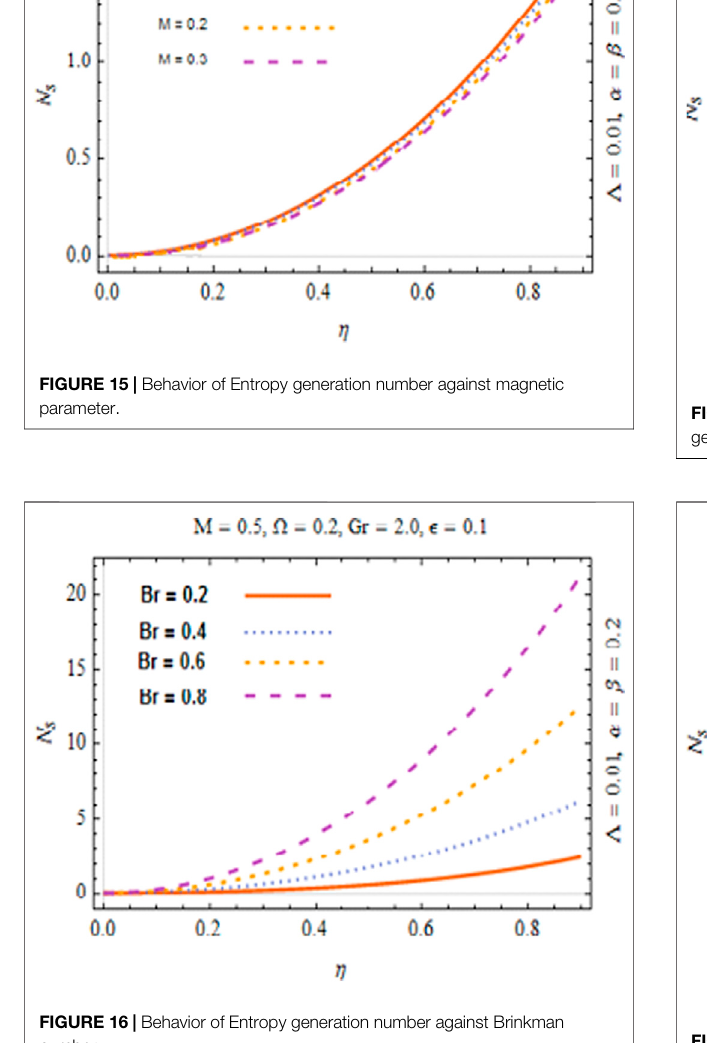
FIGURE 18 | Behavior of Entropy generation number against Grashof